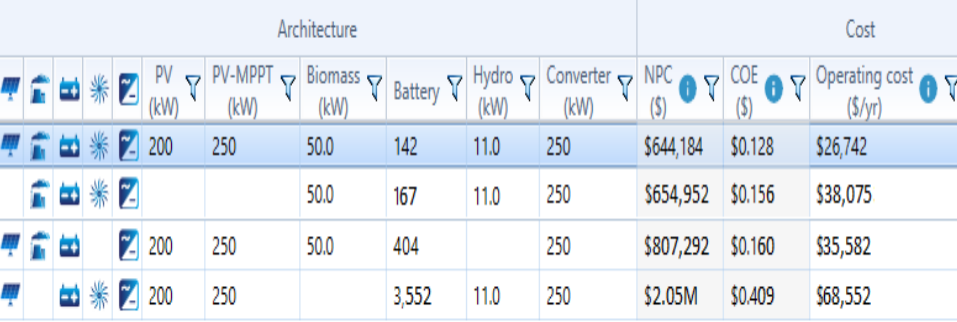
Figure 10. Optimized feasible combinations obtained from simulation.